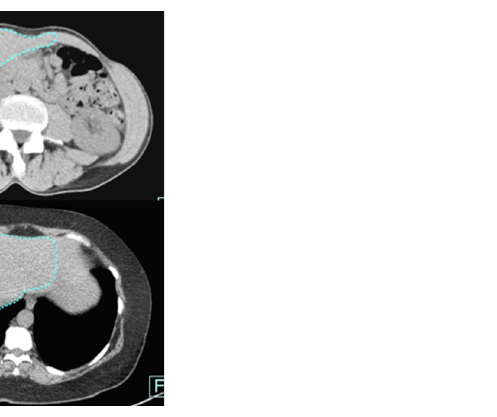
Fig 7. Pitfalls for unenhanced image data